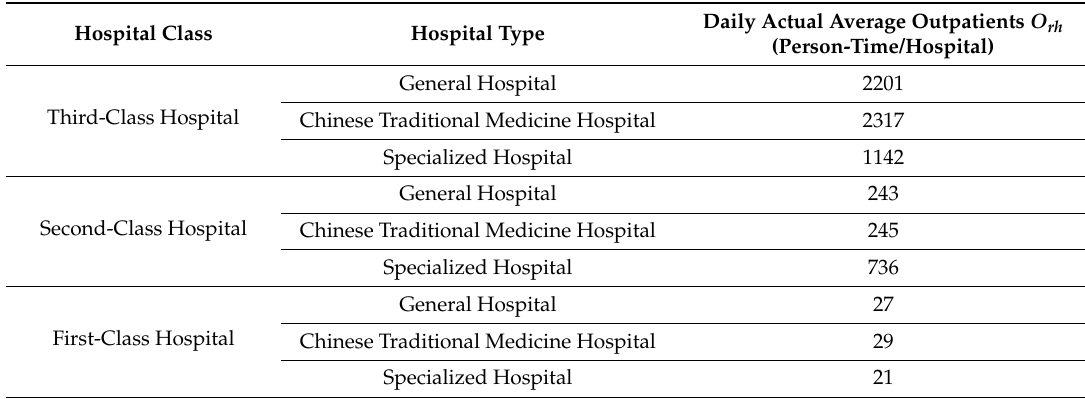
Table 5. Daily actual average of outpatients in Wuhan.